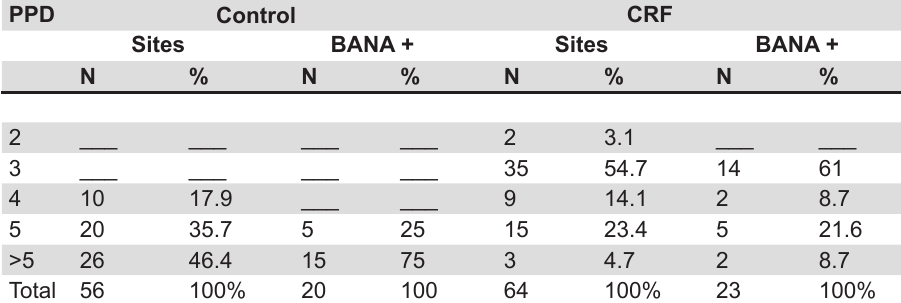
Periodontal parameters and BAnA test in patients with chronic renal failure undergoing +Table 5- Distribution of positive BANA test in different pocket probing depth (PPD) in chronic renal failure (CRF) and control groups